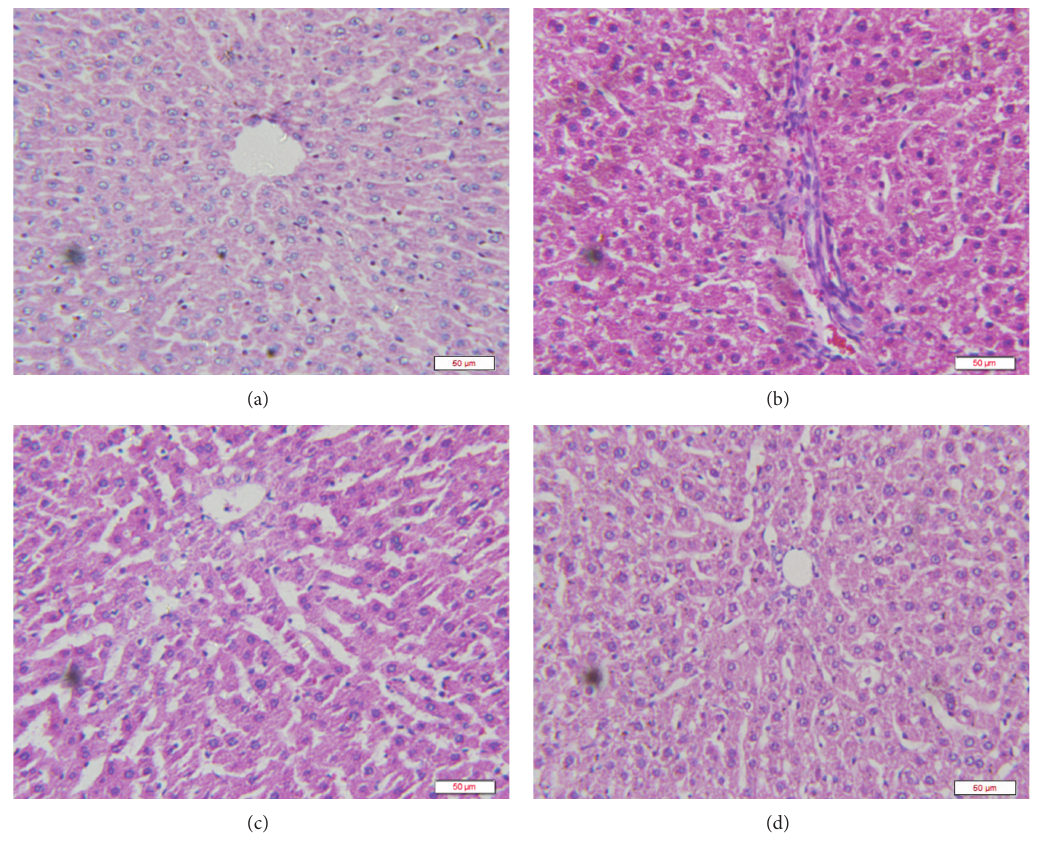
Figure 3: Effects of V 4 dipic-Cl on liver histological alterations in STZ-induced diabetic rats: (a) Control group, (b) Diabetic group, (c)